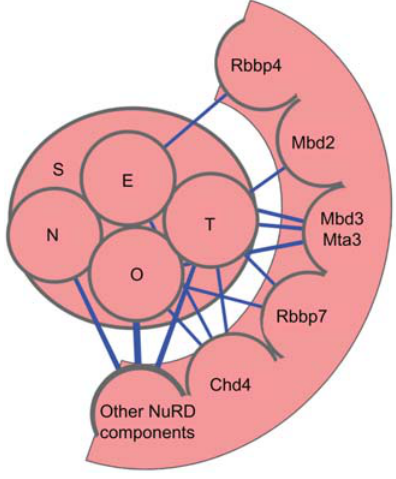
Figure 4 A core set of transcription factors comprising Sall4 (S), Esrrb (E), Nanog (N), Oct4 (O) and Tcfcp2l1 (T) show interaction with one another and with many components of the NuRD